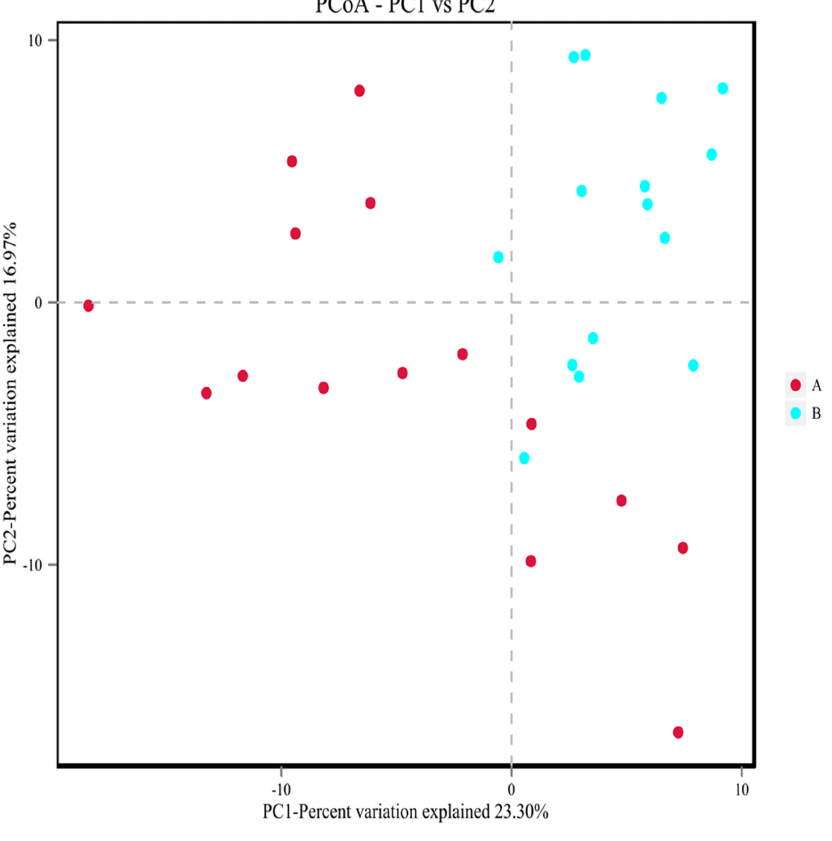
21 Figure 21. PCoA analysis of microbial communities in each group. A showed the control population group. B showed the study group. Points in the figure represent each sample separately, and groups are distinguished by different colors. The transverse and ordinate coordinates are the two eigenvalues (%) that cause the greatest difference between the samples and represent the main degree of